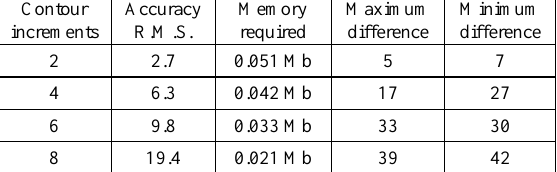
Table 1. Accuracy and memory requirements needed